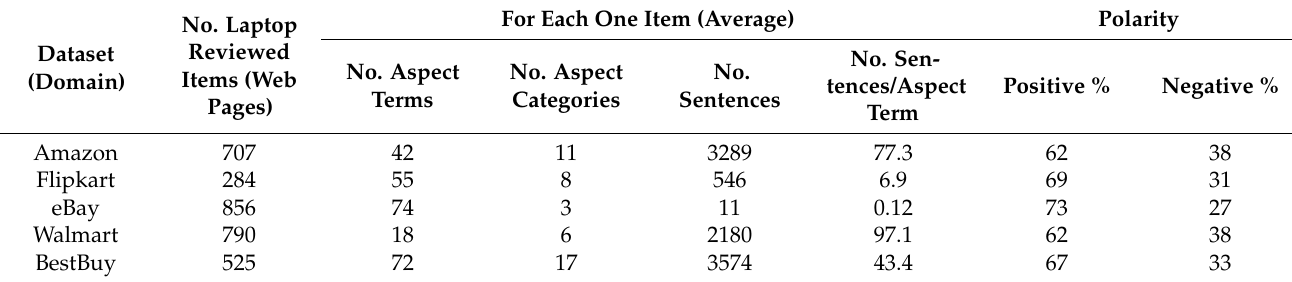
Table 2. Statistics of our LC5 (laptop collection from five EC websites)